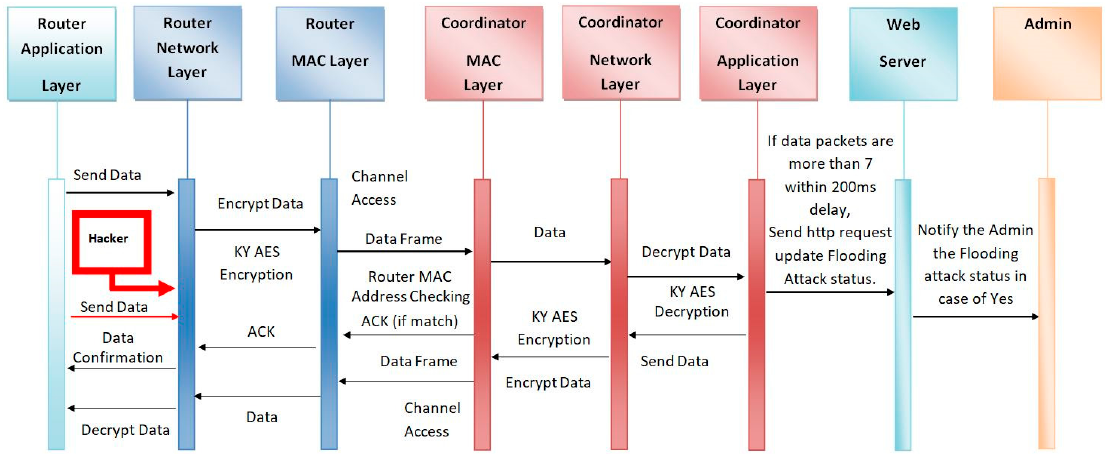
Figure 5. Sequence diagram of Router, Coordinator, Webserver, and Admin to detect Flooding Attack in the proposed Security Improvement Framework (SIF).